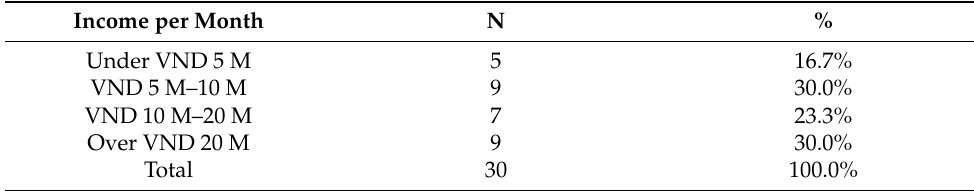
Table 6. Respondents’ income range